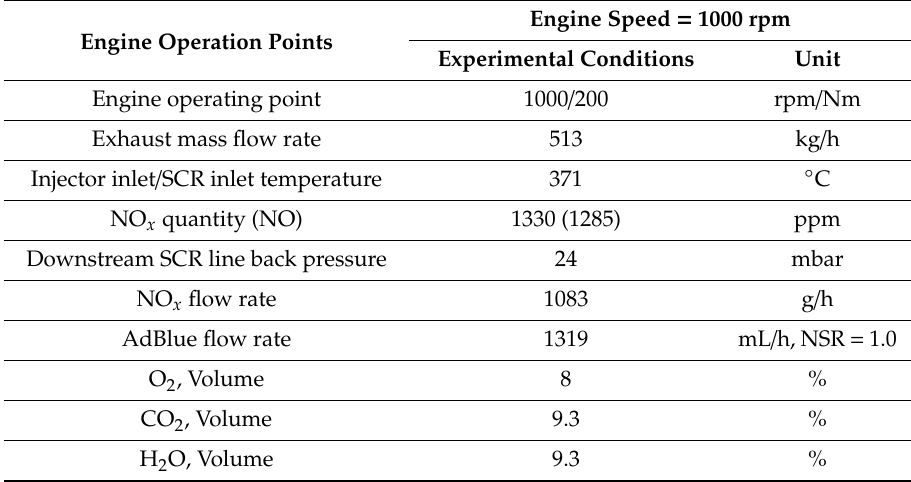
Table 3. Value of ammonia and exhaust